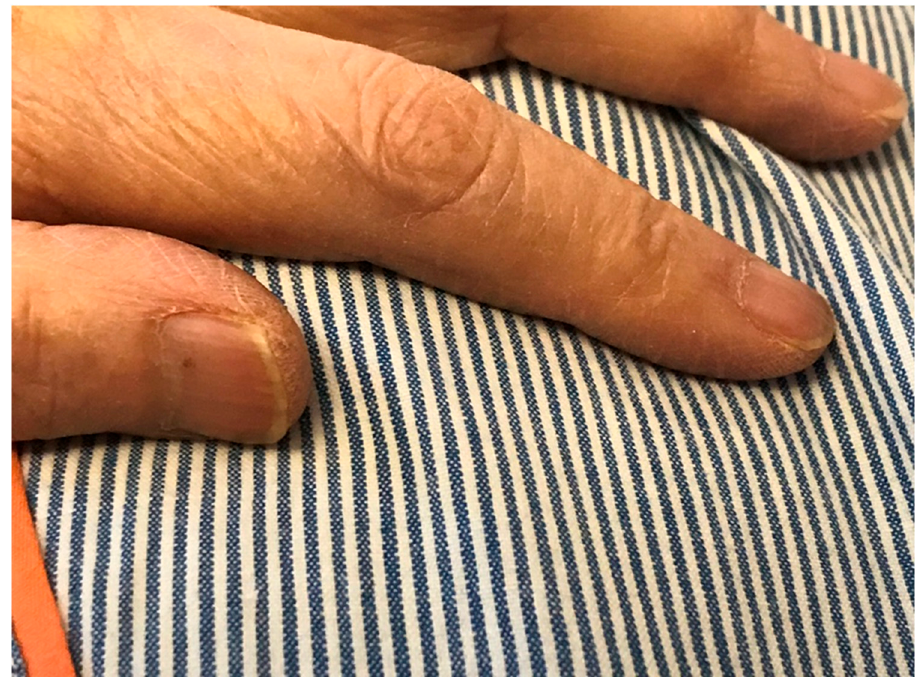
Figure 2. The patient’s white nails with sparing of the first fingernail bed.